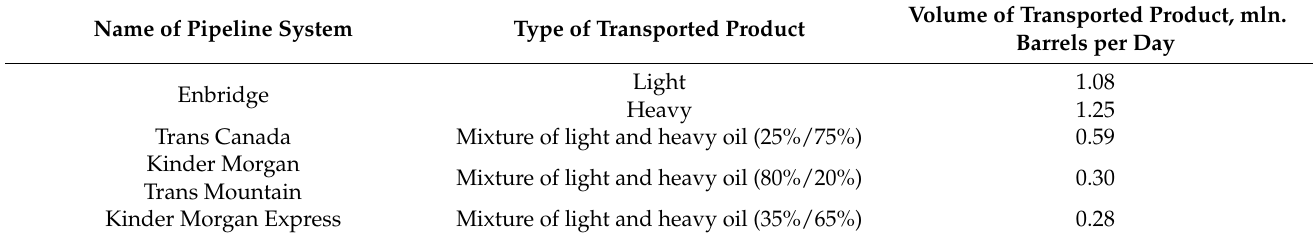
Table 1. Data on the type and volume of transported products by the North American pipeline system